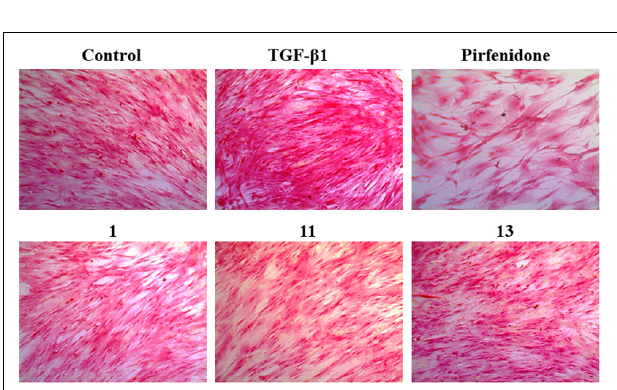
FIGURE 3 | Picro-Sirius Red (PSR) staining for the total collagen accumulation induced by TGF- β 1 in HFL1 cells. The representative pictures are the cells induced by TGF- β 1 and treated with 10 µ M compounds 1 , 11 , and 13 pirfenidone, and the control group (untreated normal cells).